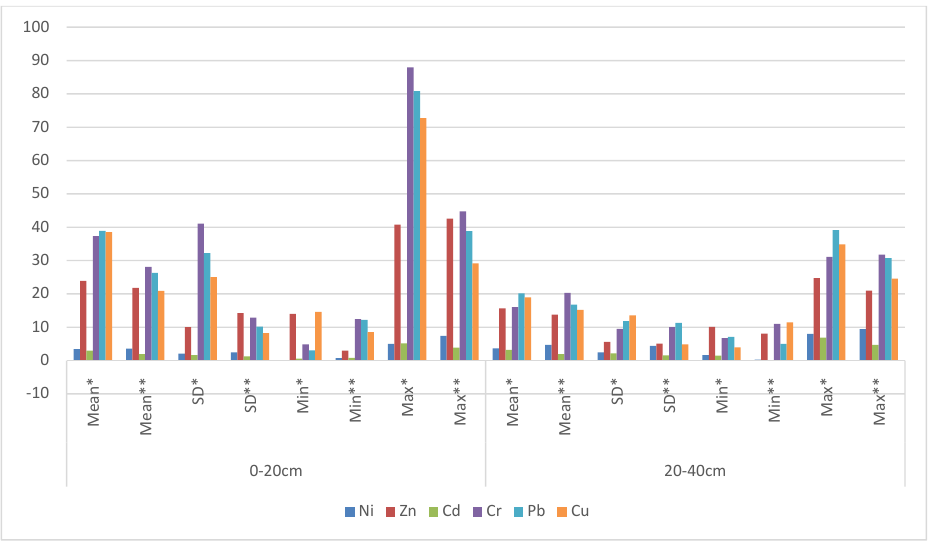
Fig. 2: Comparing the concentration of heavy metals (mg/kg) within the dumpsite and farmland at different depths